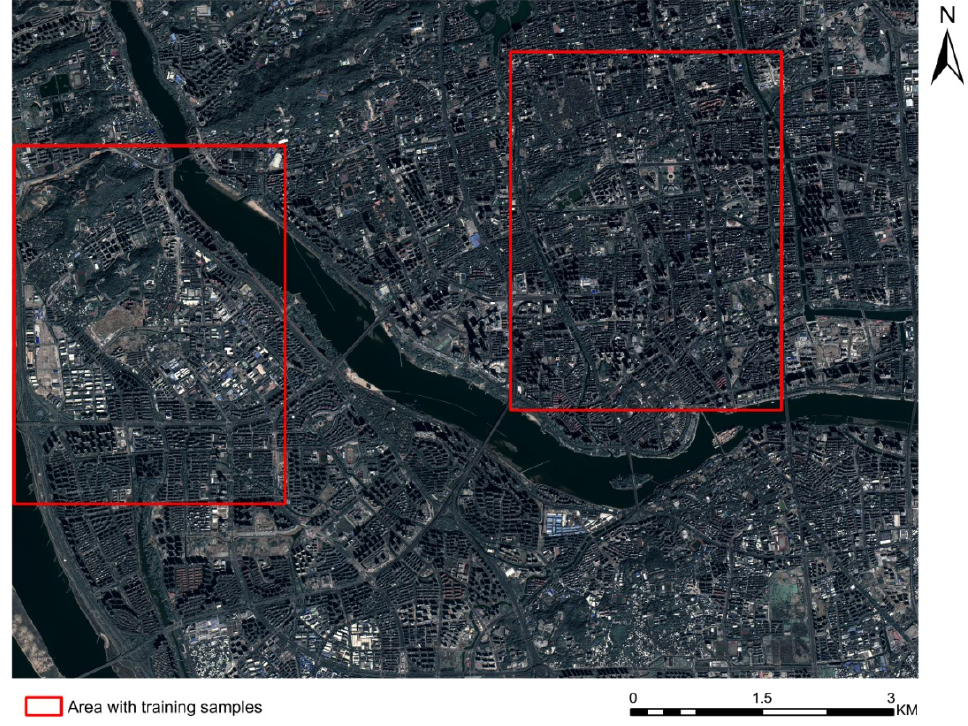
Figure 2. Overview of the study area. Red boxes refer to the subset areas of training and valida- tion